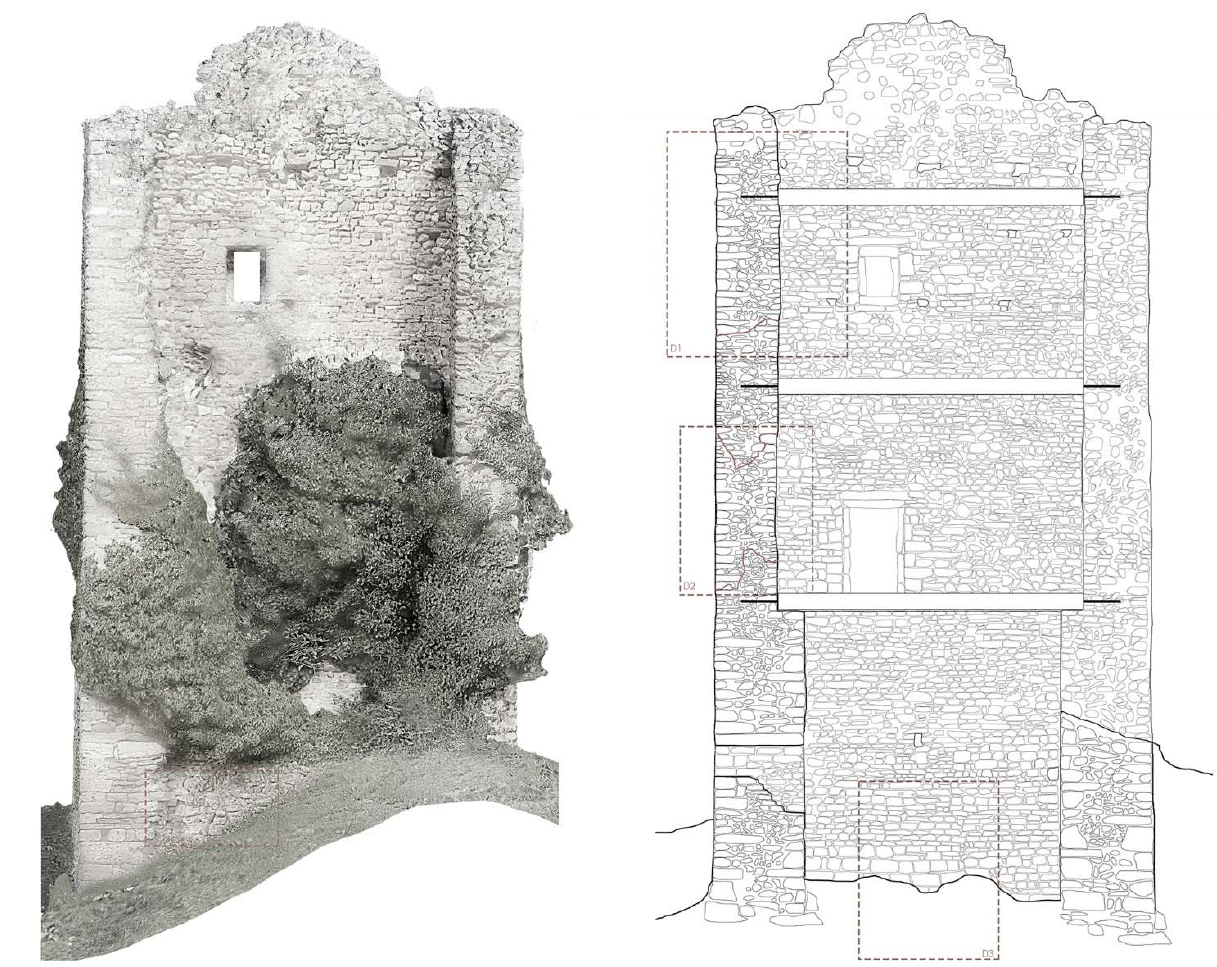
Figure 2. Castelnuovo, section of the main tower (surveyor